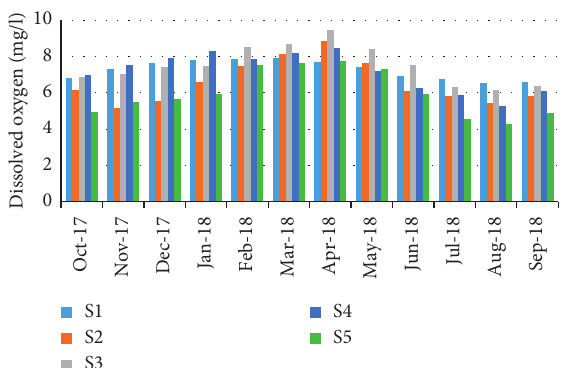
Figure 4: Spatial-temporal variation of water temperature in the Zegzel watercourse.